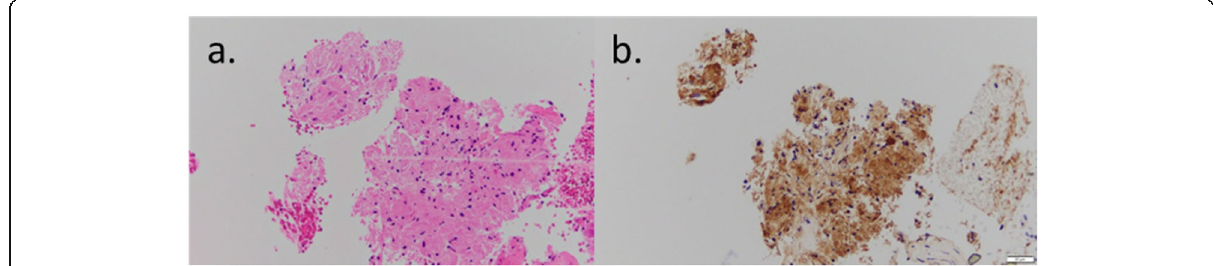
Fig. 2 The specimens by endoscopic ultrasound sonography-guided fine needle aspiration biopsy (EUS-FNAB) using a hematoxylin-eosin staining